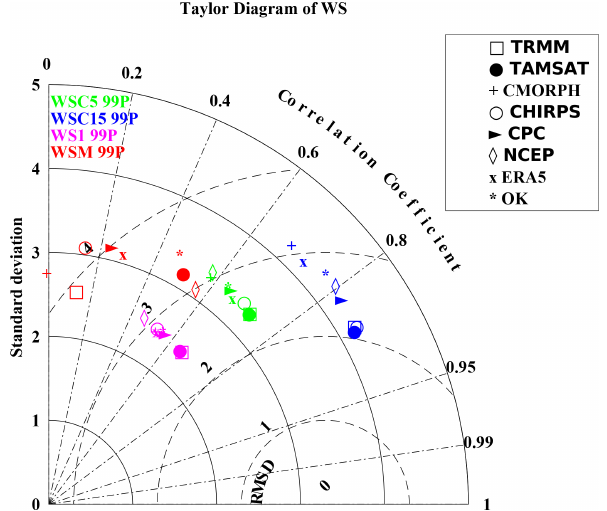
Figure 13. Taylor diagram providing three statistical scores (stan- dard deviation, correlation coefficient, root mean square deviation) in which radius expresses the standard deviation, the angle ex- presses the correlation, and the distance from the bottom right point expresses the RMSD. The OK dataset is considered as a refer- ence for comparing the spatial distribution of the four categories of wet spells WS1, WSM, WSC5, and WSC15 (99th) of the differ- ent datasets (TRMM, TAMSAT, CMORPH, CHIRPS, CPC, NCEP, ERA5, and OK). BK is used as a reference. Details on the datasets and wet spells are provided in Tables 1 and 3,